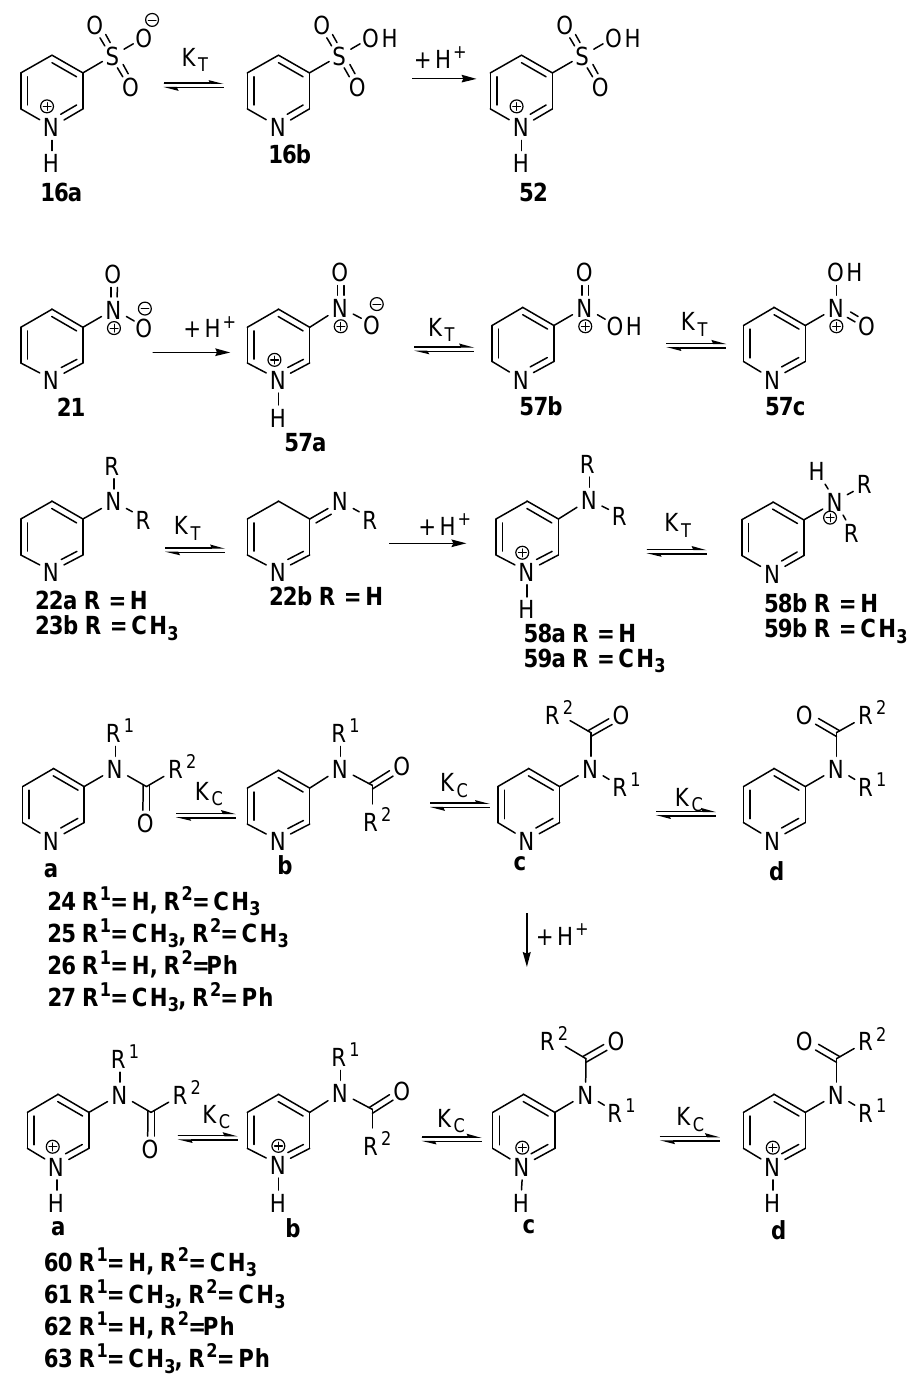
Scheme 3 The protonated forms of 3-substituted Scheme 3 . The protonated forms of 3-substitued